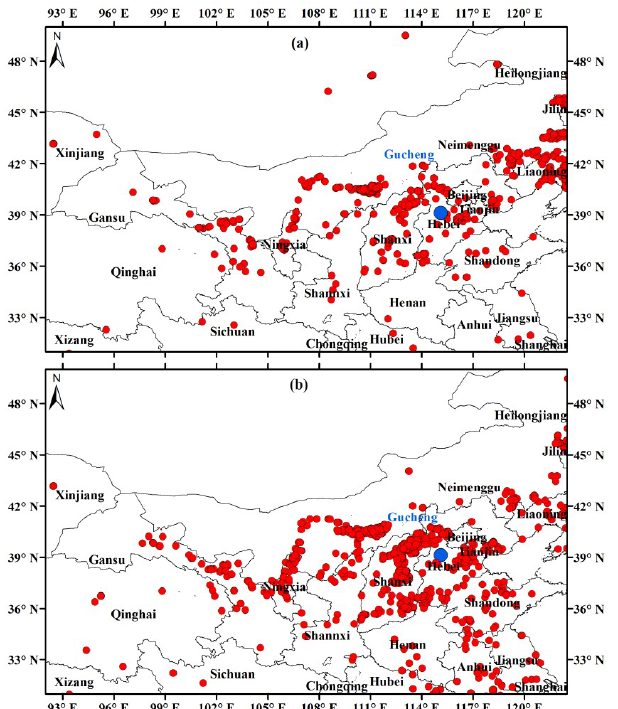
Figure 4. Fire spots at the GC site and the surrounding provinces from (a) 15–30 October 2016 and (b) 1–23 November 2016, ob- served by MODIS Terra satellites (the blue dot represents the GC station).